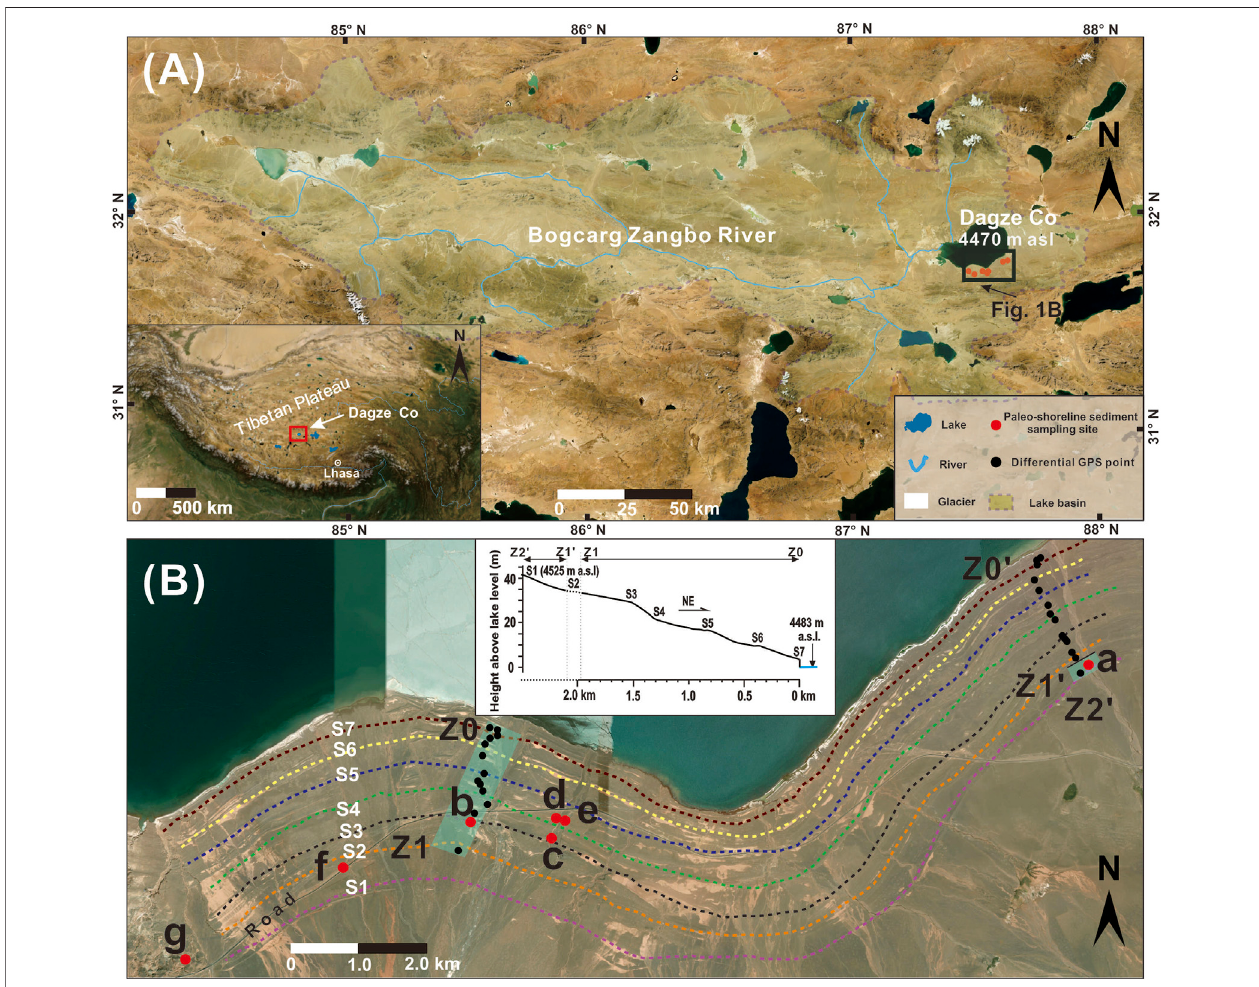
FIGURE1| StudyregionofDagzeCo. (A) ThecatchmentareaandmainriversofDagzeCo; (B) satelliteimageofthepaleo-shorelines ofDagzeCo.Redfullcircles in (A,B) represent sample locations, and black spots represent sites for differential GPS measurement. Satellite images are from the Google Earth.